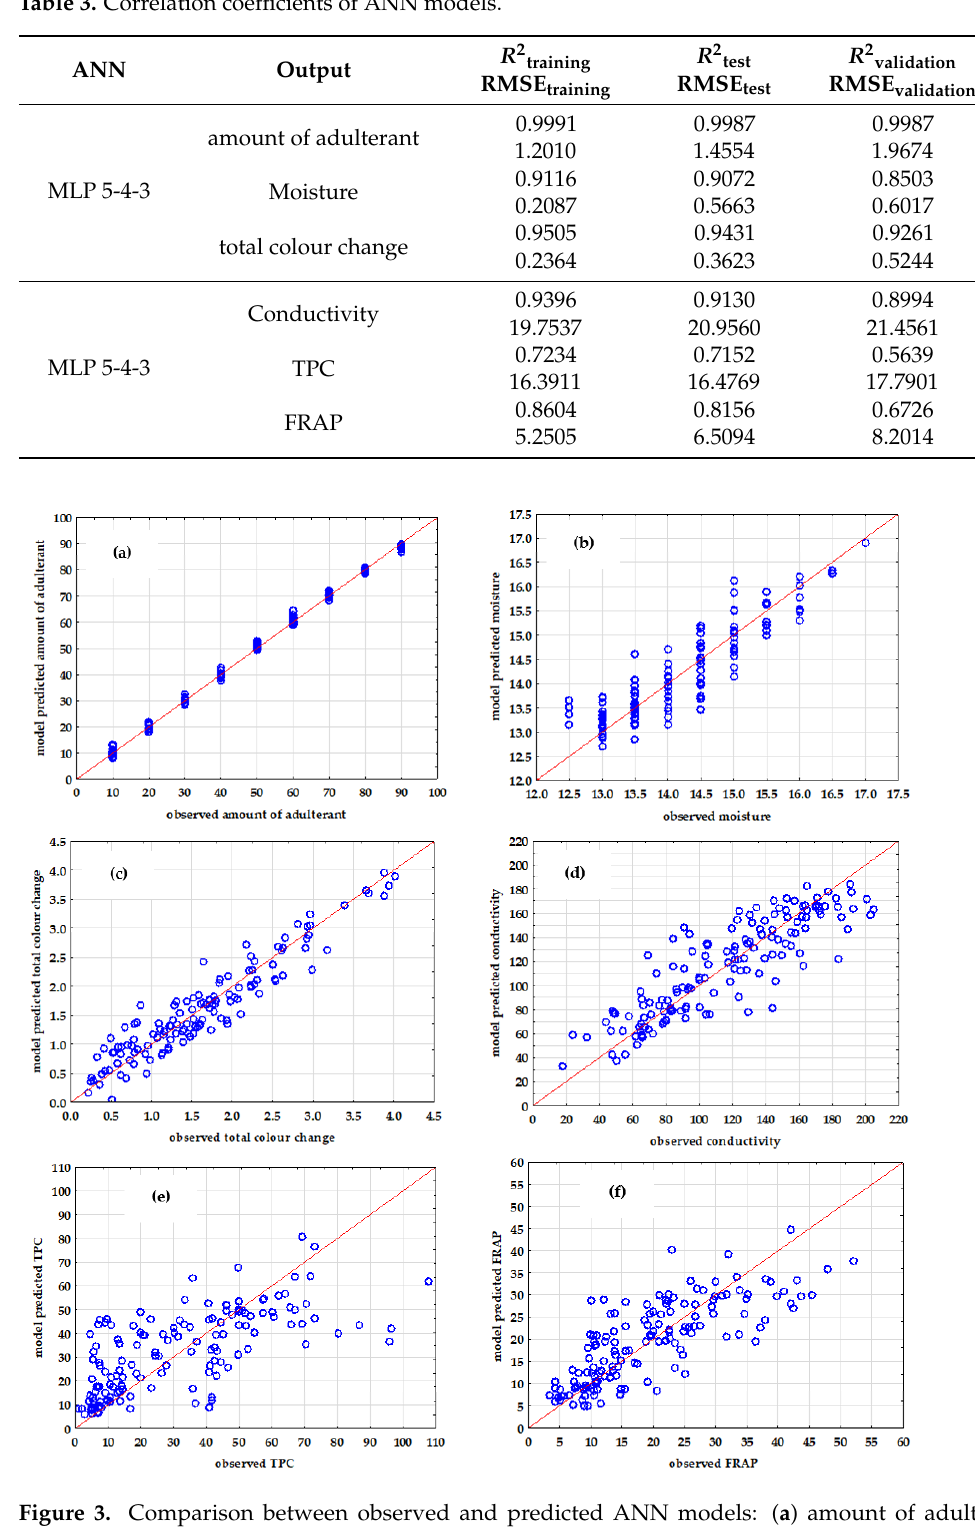
Figure 3. Comparison between observed and predicted ANN models: ( a ) amount of adulterant, ( b ) moisture content, ( c ) total colour change, ( d ) conductivity, ( e ) total phenolic content, and ( f ) antioxidant activity measured by the FRAP method. ( — experimental data)